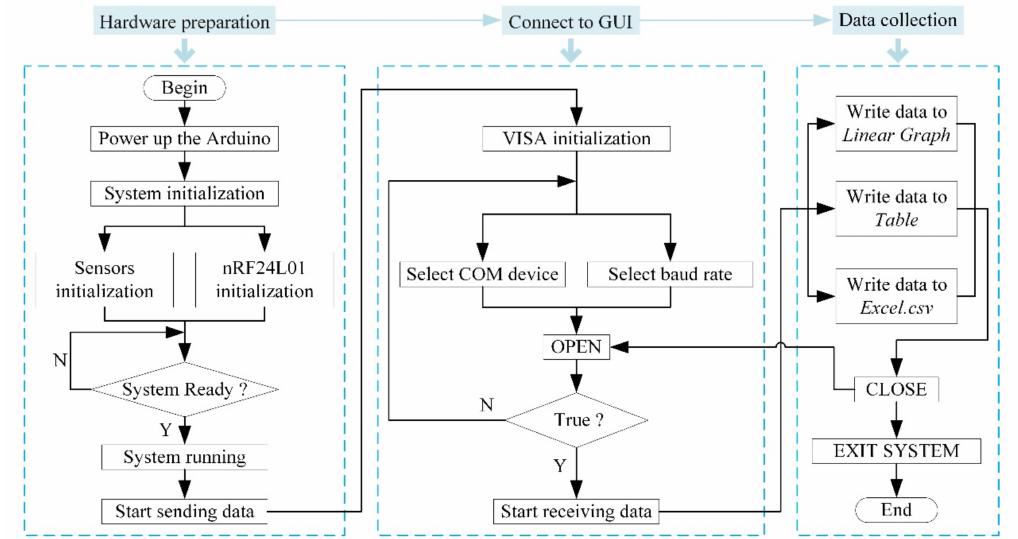
Figure 5. The application block diagram of